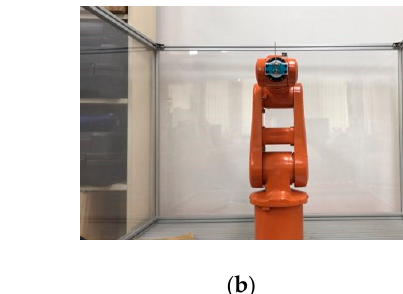
Figure 10. The velocity profiles when the robot moved 500 mm with a maximum velocity of 1000 mm/s. Table 1. Experimental results of maximum amplitude and settling time when the robot moved 500 mm with a maximum velocity of 1000 mm/s. 𝒕 𝒂 ,𝒕 𝒅 (𝐬) 𝒕 𝒄𝒐𝒏𝒔𝒕 (𝐬) Max. Amplitude (mm)